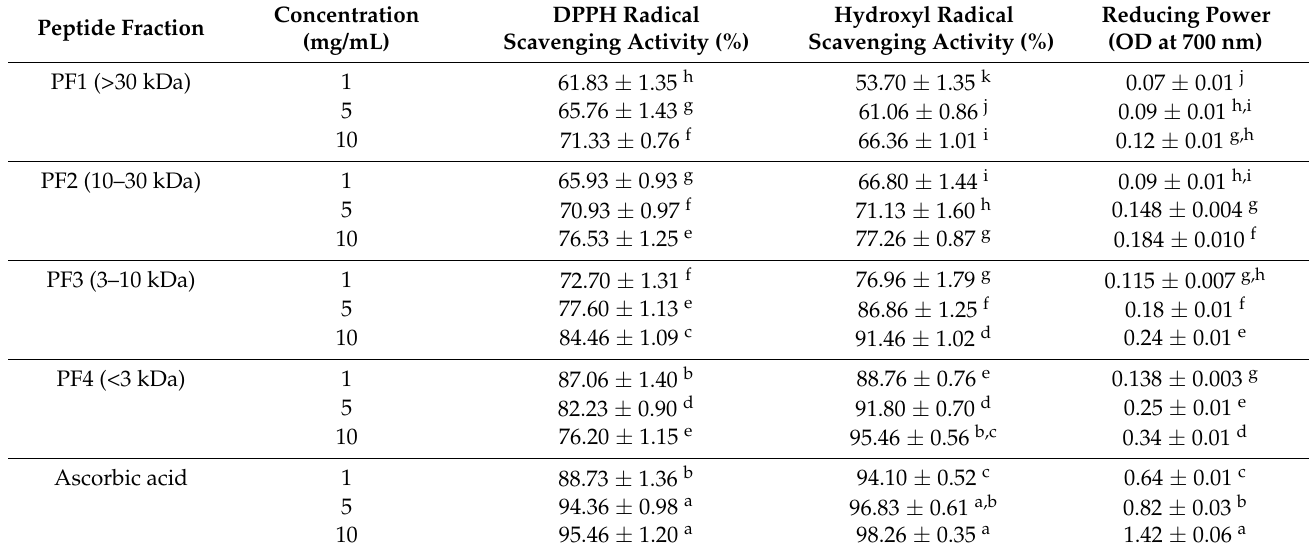
Table 2. Antioxidant activity of the isolated peptide